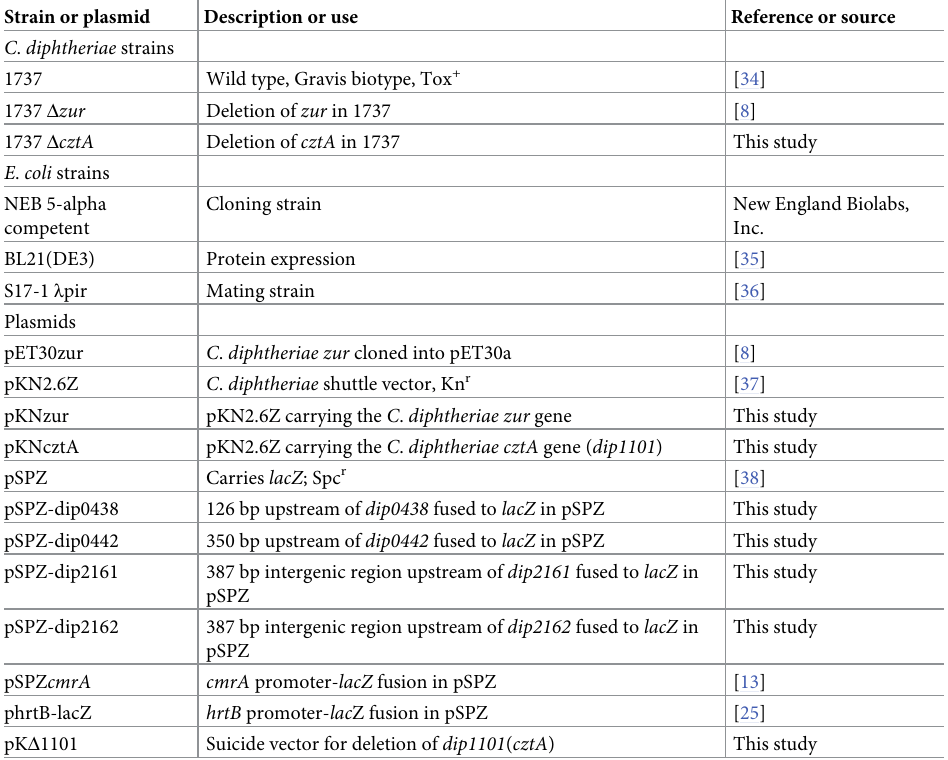
Table 2. Strains and